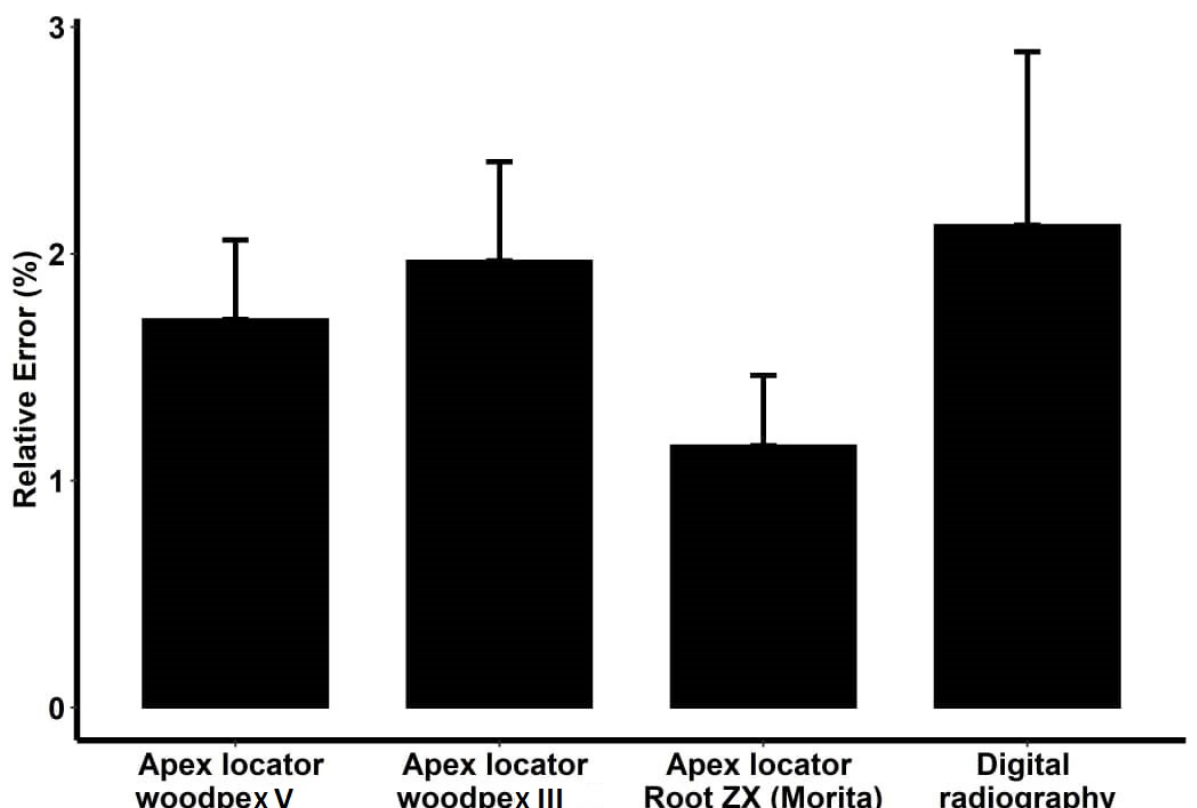
Figure 4. Relative error of the four modalities based on the actual working length in the samples with central apical foramen.